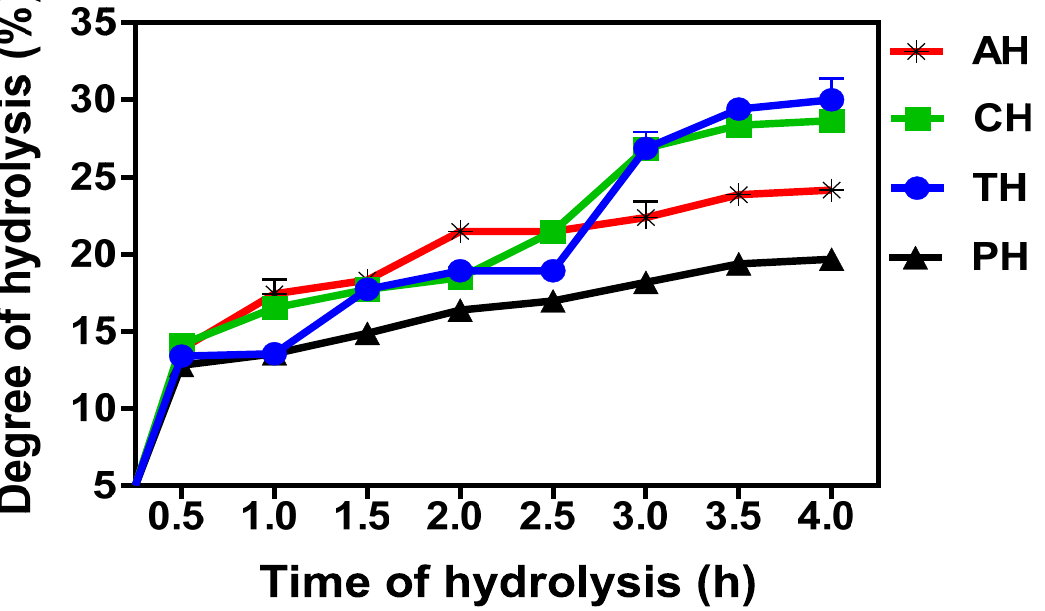
Figure 1. Degree of hydrolysis of alcalase (AH), chymotrypsin (CH), pepsin (PH) and trypsin (TH) eggplant leaf protein hydrolysates.